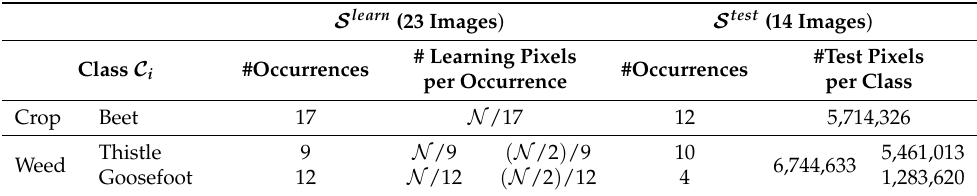
Table 2. The number of learning and test pixels for crop/weed detection (left sub-column)